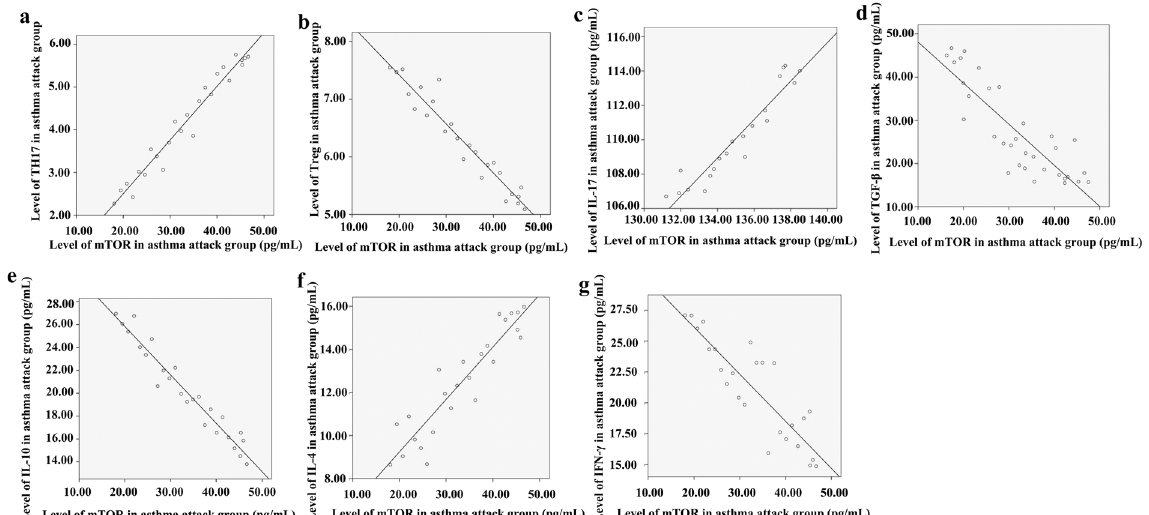
Figure 2. Correlation of serum mTOR levels with the loss of Th17/Treg and Th1/Th2 balances in patients experiencing an asthma attack. The asthma patient group comprised children with asthma who visited a doctor or were hospitalized from January 2014 to June 2014. Serum was collected from the fasting venous blood of these patients, and mTOR as well as the cytokines were measured by ELISA. Peripheral blood mononuclear cells (PBMC) were isolated from the fasting venous blood of these patients, and Th17 and Treg were measured by flow cytometry. ( a ) Positive correlation between the amounts of serum mTOR (pg/mL) determined by ELISA and PBMC Th17 cells (%) determined by flow cytometry in patients experiencing an asthma attack. Correlation analysis performed with Pearson correlation, r = 0.960 and p < 0.001. ( b ) Negative correlation between the amounts of serum mTOR (pg/mL) determined by ELISA and PBMC Treg cells (%) determined by flow cytometry in patients experiencing an asthma attack. Correlation analysis performed with Pearson correlation, r = − 0.932 and p < 0.001. ( c ) Positive correlation between the amounts of serum mTOR (pg/mL) and serum IL-17 (pg/mL) determined by ELISA in patients experiencing an asthma attack. Correlation analysis performed with Pearson correlation, r = 0.754 and p < 0.001. ( d ) Negative correlation between the amounts of serum mTOR (pg/mL) and serum TGF- β (pg/mL) determined by ELISA in patients experiencing an asthma attack, r = − 0.740 and p < 0.05 by Pearson correlation analysis. ( e ) Negative correlation between the amounts of serum mTOR (pg/mL) and serum IL-10 (pg/mL), determined by ELISA in patients experiencing an asthma attack, r = − 0.944 and p < 0.001 by Pearson correlation analysis. ( f ) Positive correlation between the amounts of serum mTOR (pg/mL) and serum IL-4 (pg/mL) determined by ELISA in patients experiencing an asthma attack, r = 0.855 and p < 0.001 by Pearson correlation analysis. ( g ) Negative correlation between the amounts of serum mTOR (pg/mL) and serum IFN- γ (pg/mL) determined by ELISA in patients experiencing an asthma attack, r = − 0.762 and p < 0.001 by Pearson correlation